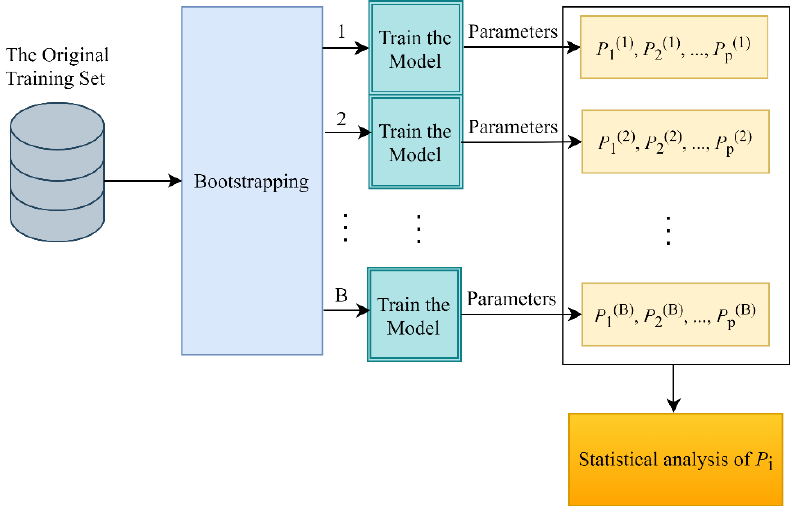
Figure 4. The overall structure of parameter confidence analysis.